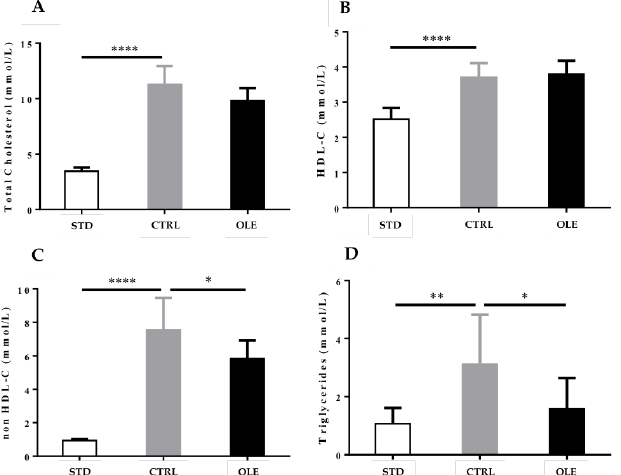
Figure 2. Oleactiv ® modulation of hamsters’ lipid profile: analysis of total cholesterol